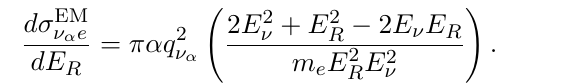
= 10 − 9 e ( q ν = 10 − 9 e and q ν = 10 − 8 e ). The µ µ e